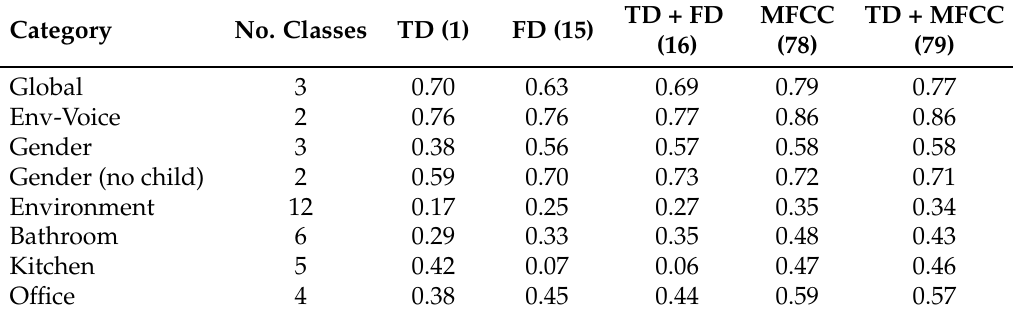
Table 3. Support vector machine (SVM) classification Results, RET in brackets for each feature.